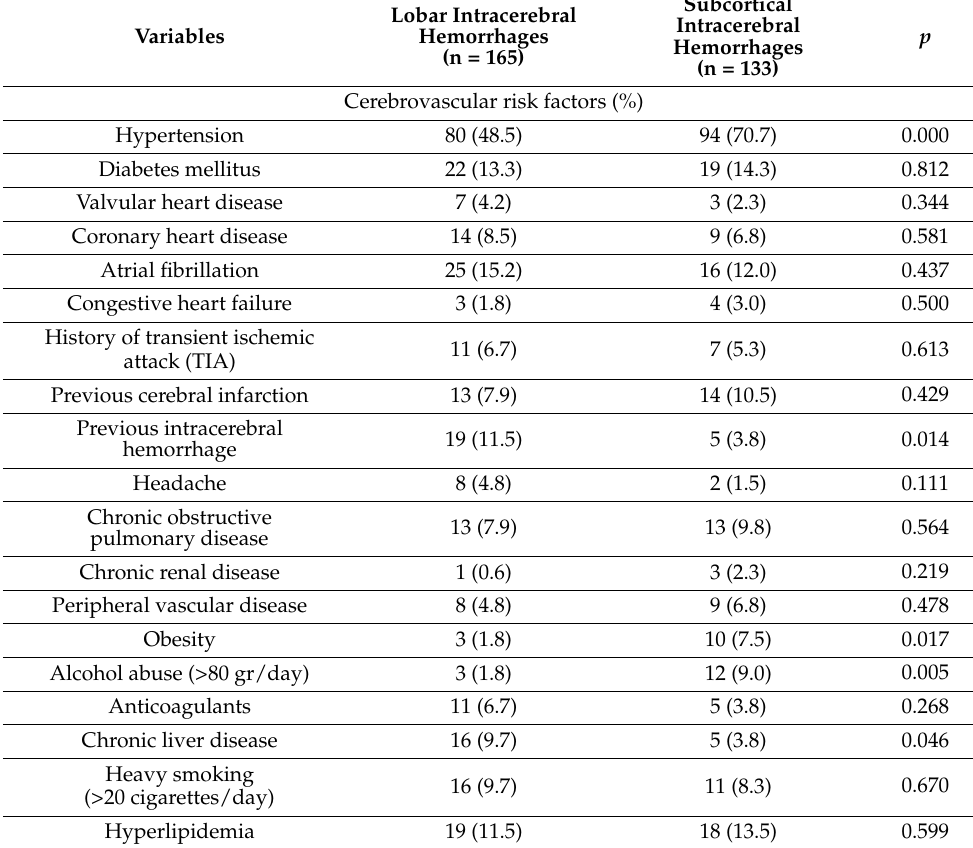
Table 3. Cerebrovascular risk factors, clinical features, and outcomes between patients with lobar versus deep subcortical intracerebral